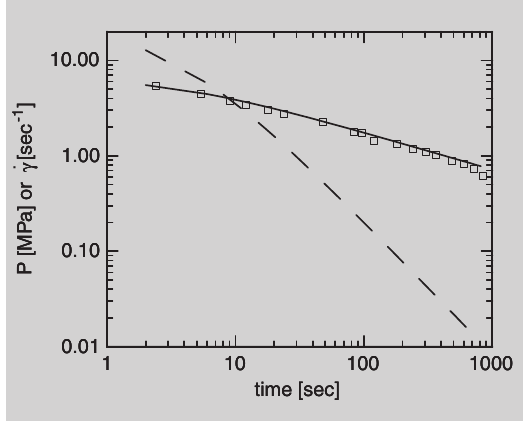
Figure 13: Long-time pressure decay trend for PVMQ compound in 20:1 die at 120˚C. Solid line: P [MPa], dashed line: